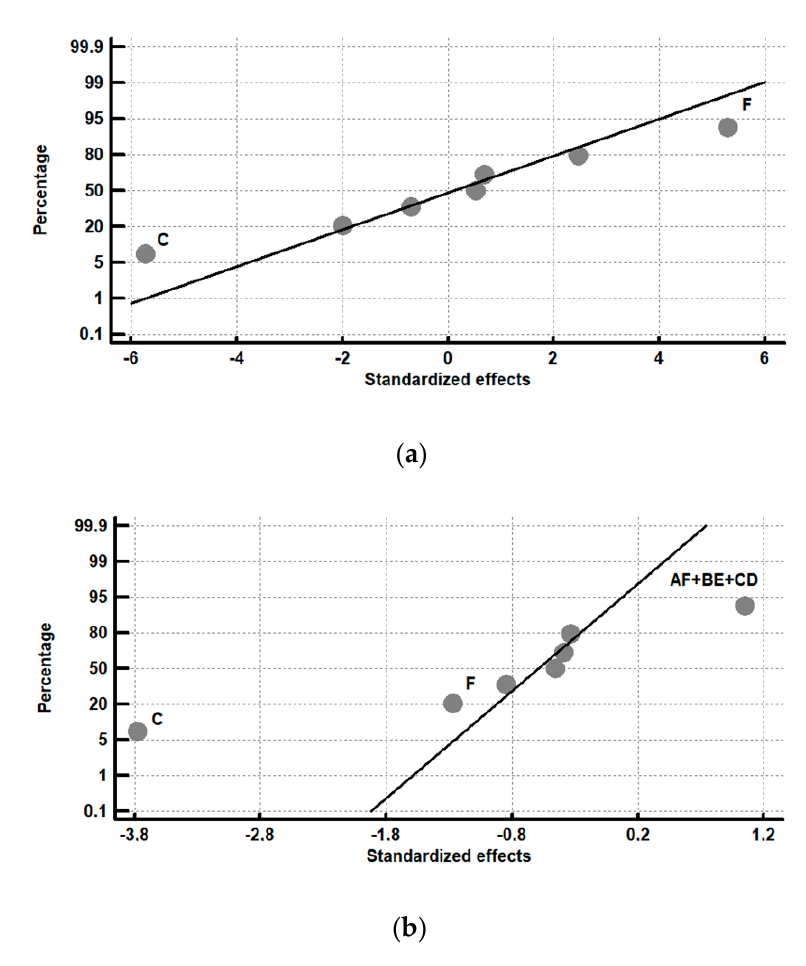
Figure 5. Representation of the effects in a normal probability paper on Vol.% carbides. (a) Zone I; (b) zone III. Table 8. Vol.% carbides in zone III. Analysis of the effects corresponding to the interactions AF + BE + CD and F + BC +